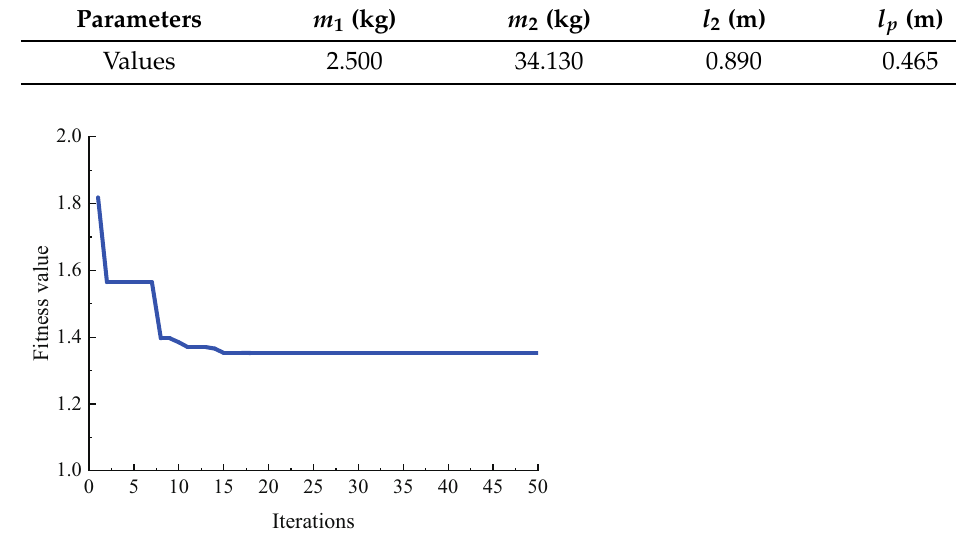
Figure 3. Fitness value of each iteration with l 1 = 1 m.